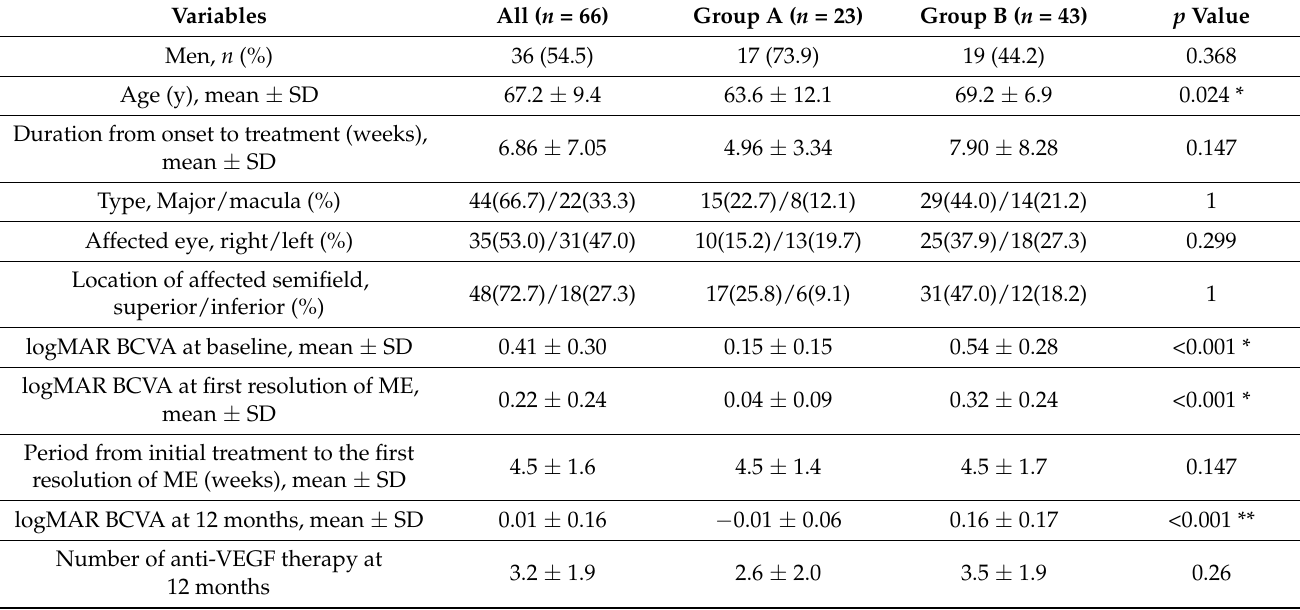
Table 1. Baseline patient